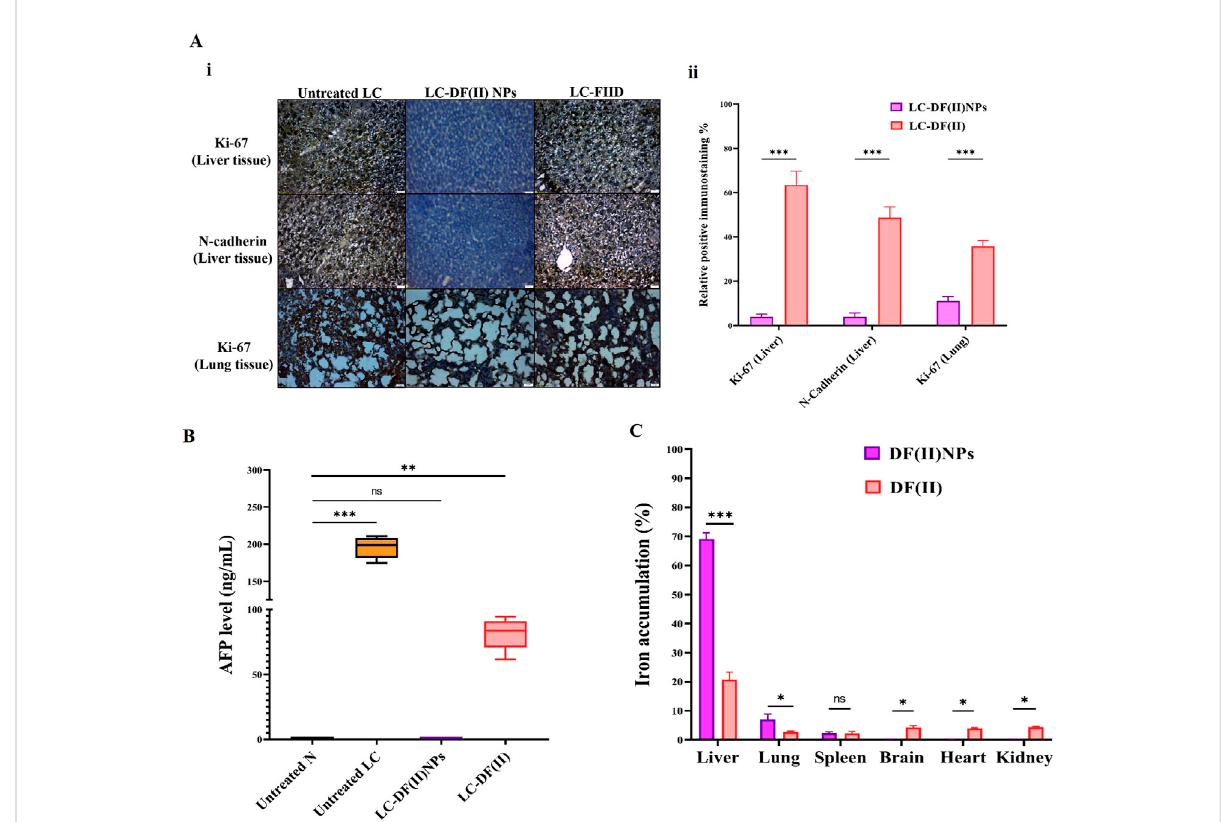
FIGURE 3 ImmunohistologicalandbiochemicalinvestigationsofDF(II)complexesimpactontumormarkersaswellasbiodistribution. (A) Immunostaining for Ki-67 and N-cadherin in tumor tissues (liver and lung) as illustrated by (I) microscopic captured images and ( II ) the percentages of positive immunostained cells. Data are shown as mean ± SEM. LC-DF(II) NPs group was compared to LC-DF(II) group, considering statistically signi fi cant at p ≤ 0.05*, ≤ 0.005**, and ≤ 0.001***. (B) Blood level of α -fetoprotein (AFP, ng/mL). Healthy N group was compared to the untreated and DF(II) complexes-treatedLCgroups,considering statistically signi fi cantat p ≤ 0.05*, ≤ 0.005**, and ≤ 0.001***. (C) BiodistributionofDF(II) NPsandDF(II)in liver, lung, and other tissues of the treated LC groups. Data are shown as mean ± SEM. LC-DF(II) NPs group was compared to LC-DF(II) groups, considering statistically signi fi cant at p ≤ 0.05*, ≤ 0.005**, and ≤